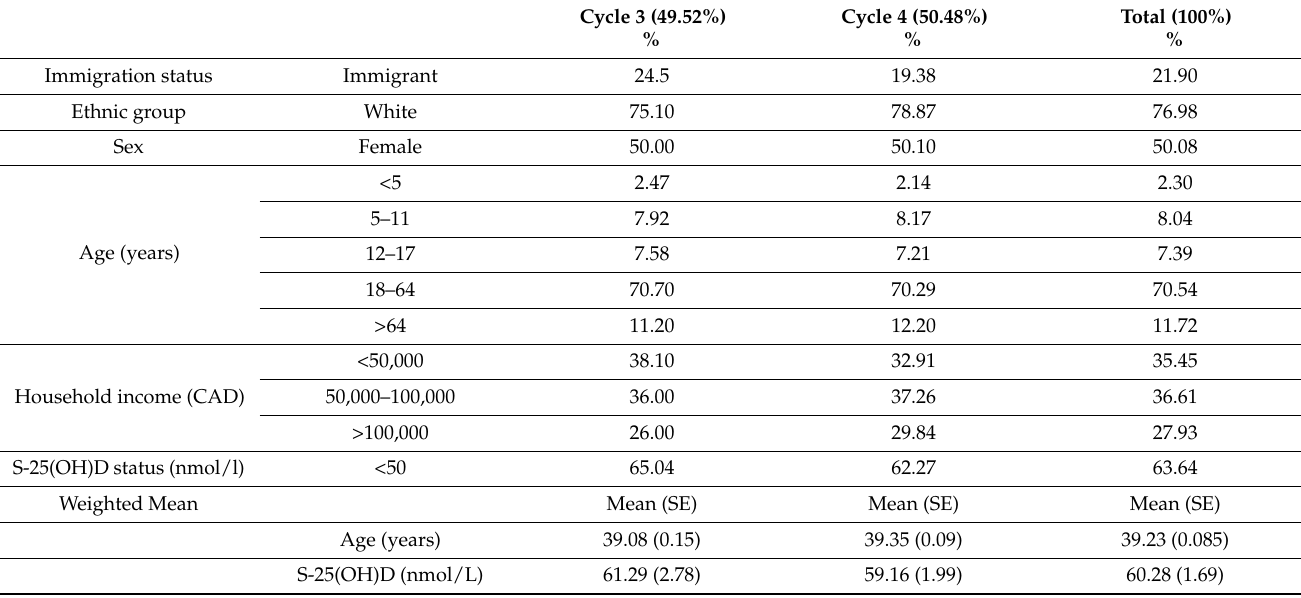
Table A2. Weighted prevalence and mean S-25(OH)D (nmol/L) levels and basic study characteristics using Cycles 3 and 4 of Canadian Health Measures Survey